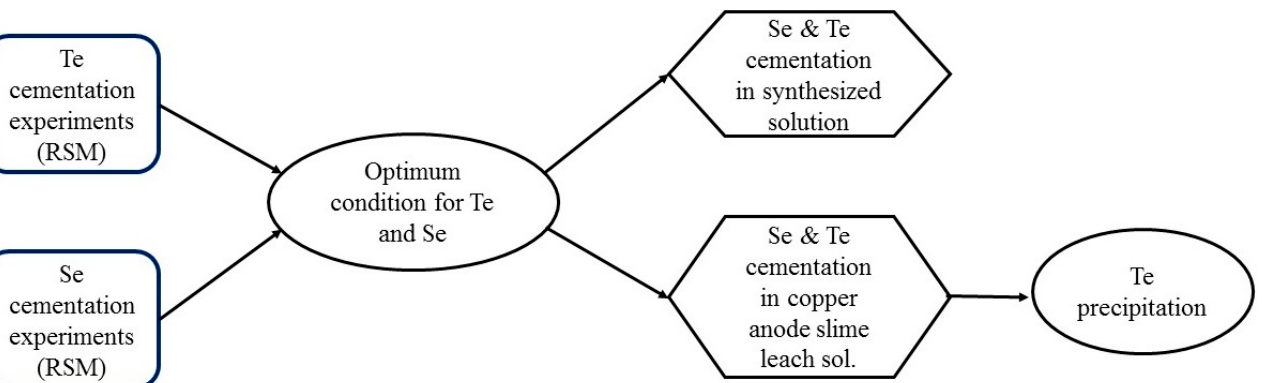
Table 1. Analysis of primitive pregnant solution from copper anode slime leaching .